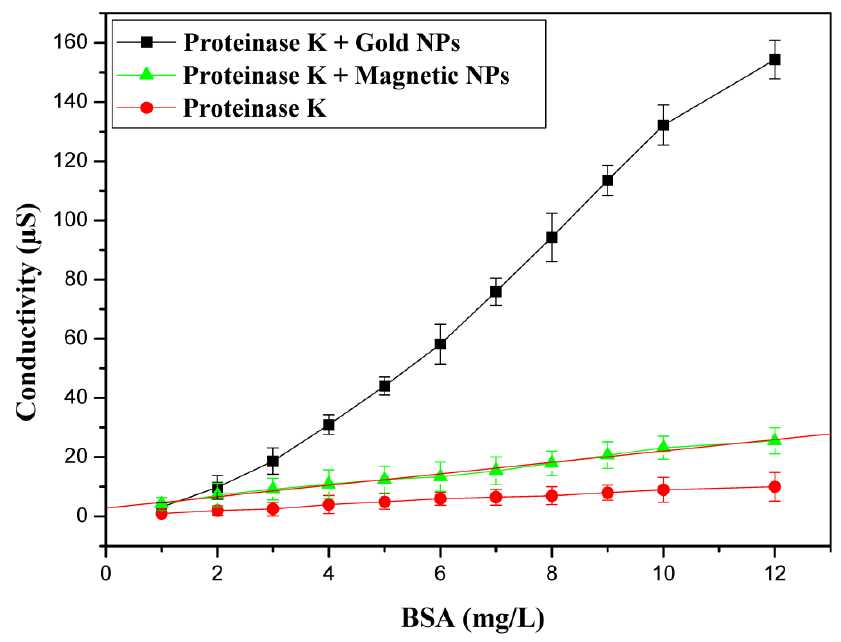
Figure 3. Calibration curves of the proteinase K biosensor, with and without nanoparticles (AuNPs and